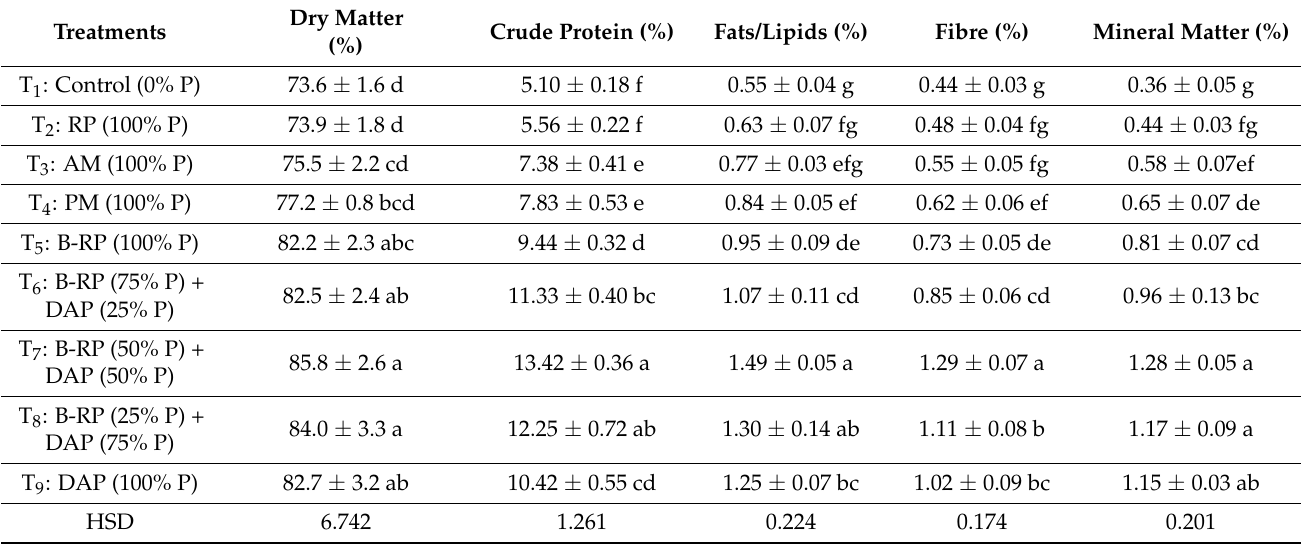
Table 3. Effect of different combinations of B-RP and DAP on nutritional quality parameters of wheat. Dry Matter Crude Protein (%) Fats/Lipids (%) Fibre (%) Treatments